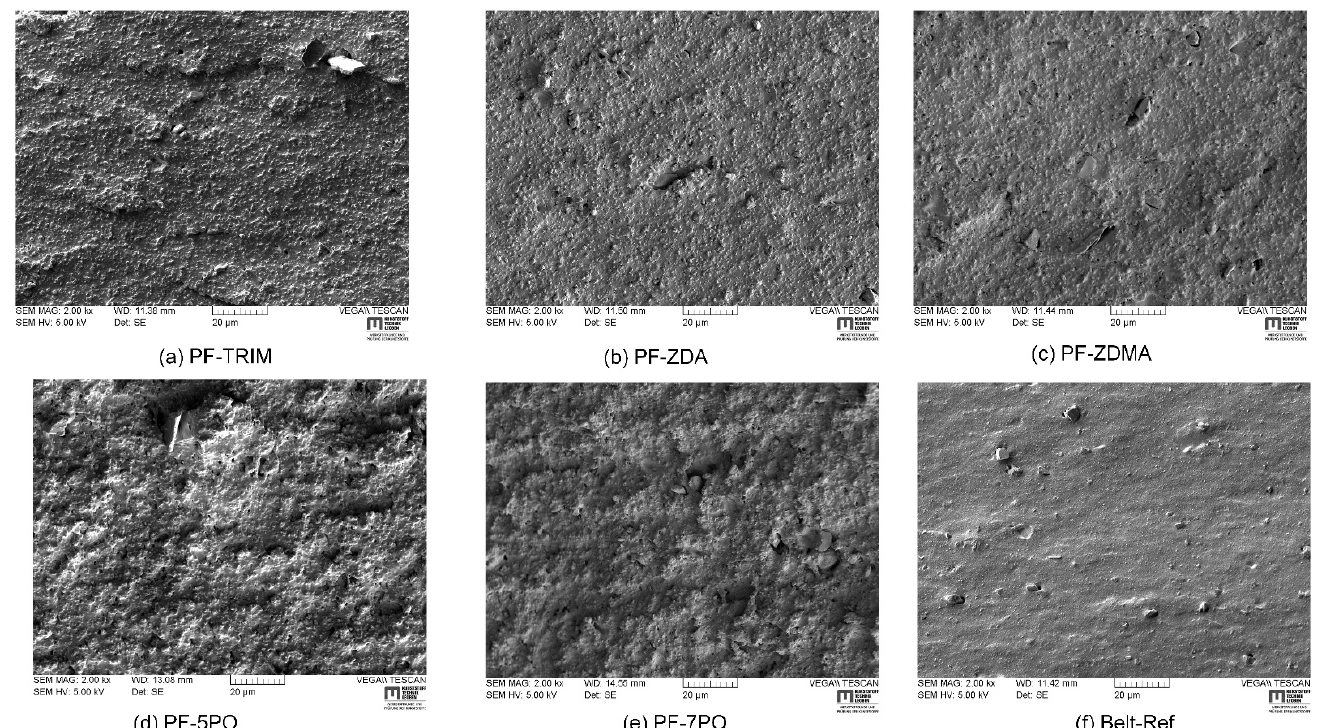
Figure 4. SEM images at 2000× magnification of fracture surfaces of 24 h postcured hybrid reinforced compounds.